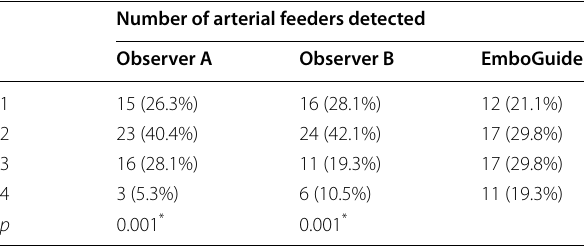
p: p value for Chi-square test for association between actual with observer A & observer B and EmboGuide * : Statistically significant at p 0.05 ≤ Table 4 Comparison between EmboGuide with observer A and observer B ( n 57) =